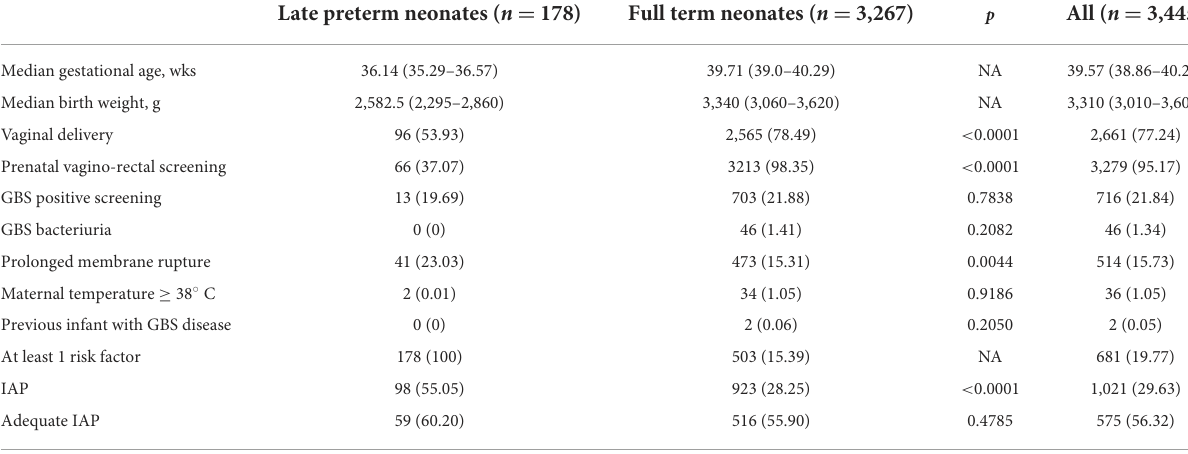
TABLE 2 Demographics, risk factors for EOS and intrapartum antibiotic